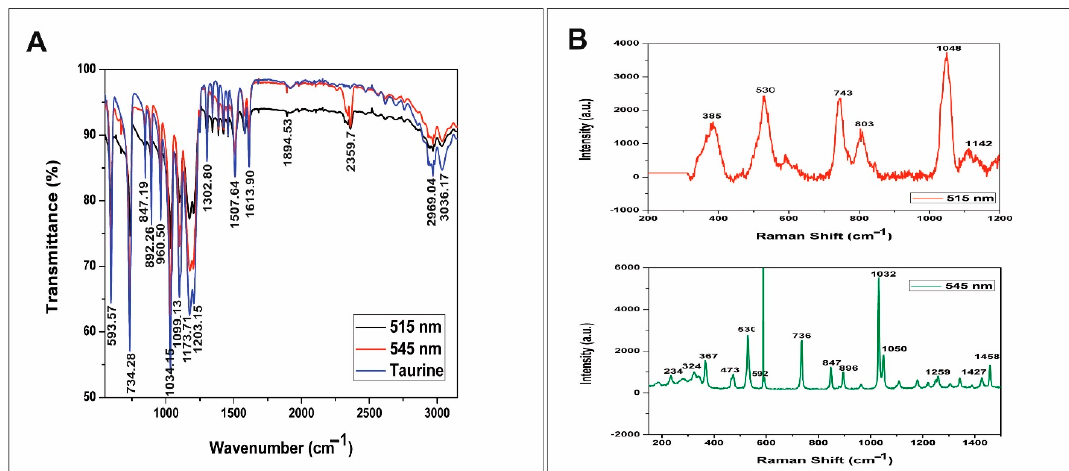
Figure 6. Spectra of the bulk compound taurine and the taurine-capped gold nanospheres are shown in ( A ). The characteristic bands represent the interactions between taurine and the gold nanospheres. ( B ) showed the Raman spectra of the λ max 515 nm and λ max 545 nm gold nanospheres capped with taurine, thus depicting their molecular vibrations.